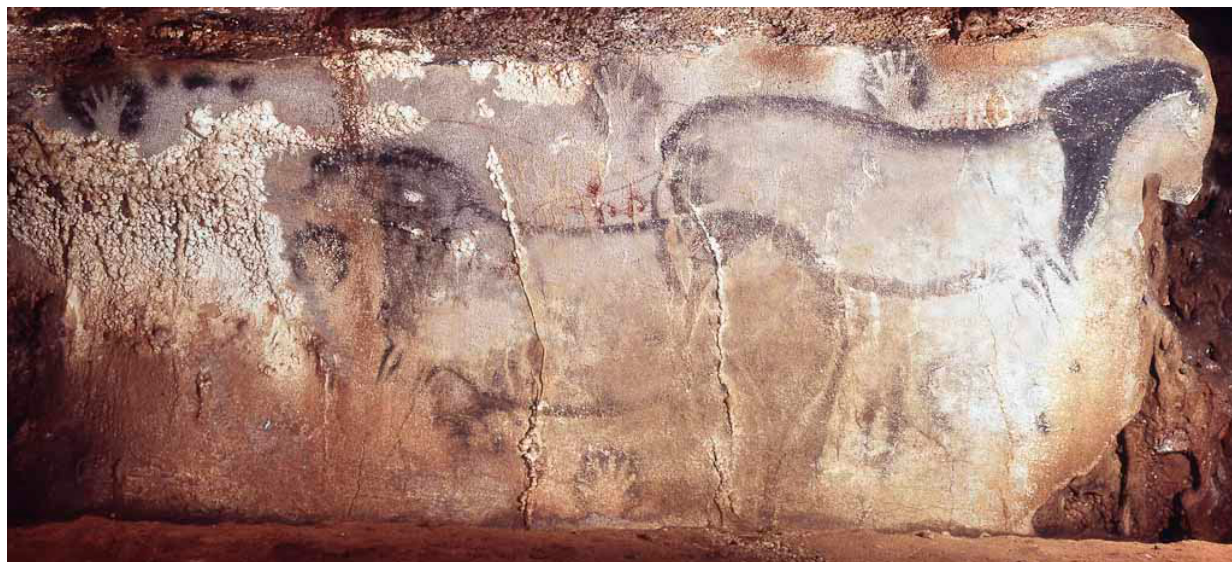
Figure 7. Spotted Horses panel with spots removed by author.